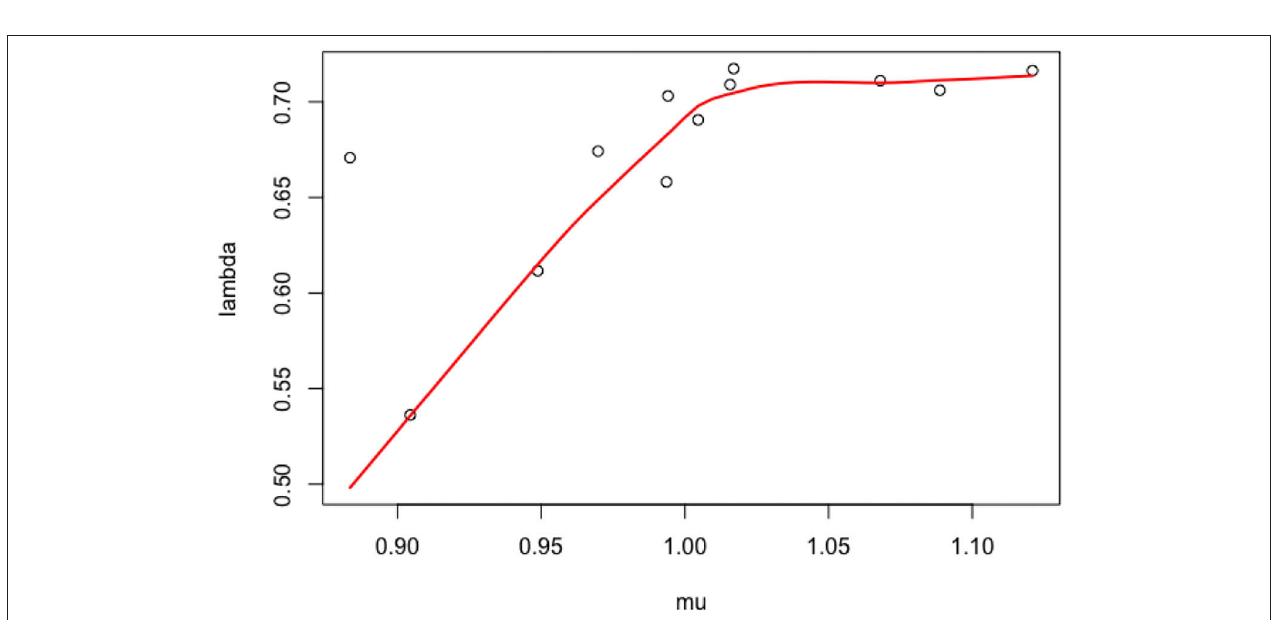
FIGURE 4 | Scatter plot of the individual parameters ( k nf , i , k pf , i ).